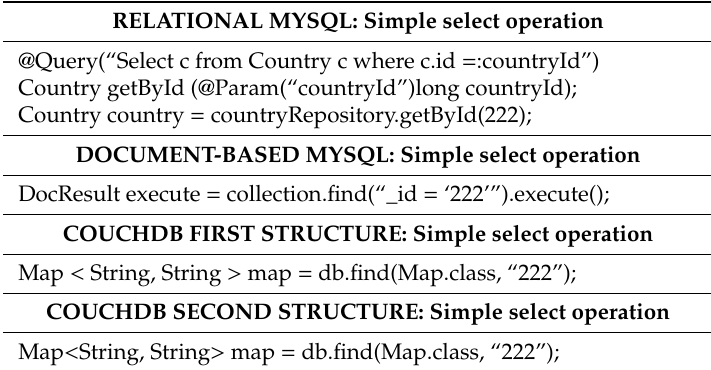
Table 4. Simple select